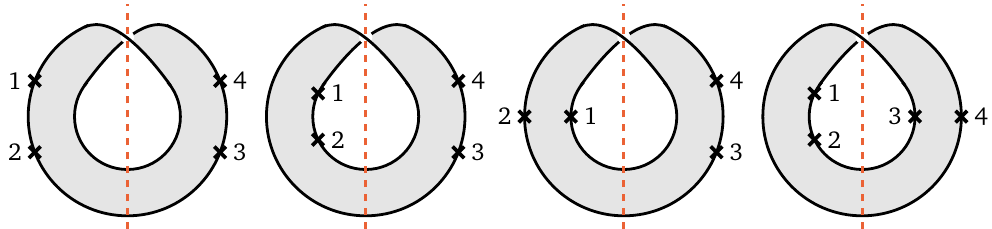
Figure 16: The four different cuttings of the Möbius strip amplitude in the s -channel. They correspond to the four regions Γ ( 1 ) ,..., Γ ( 4 ) (in this